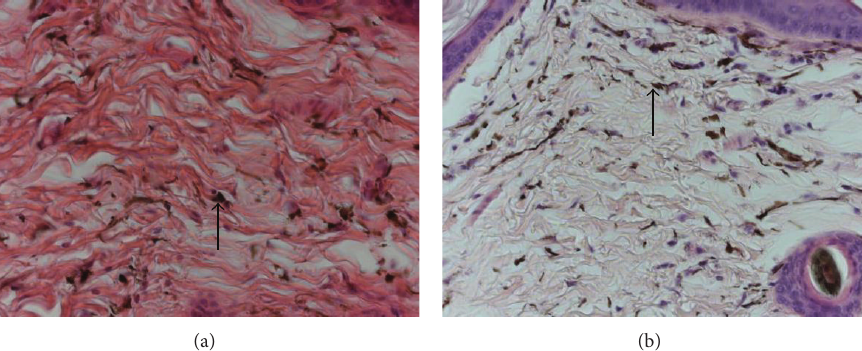
Figure 2: Photomicrographs of dermis from dorsal skin of the four-striped mouse. Pigment-containing cells (arrow) are homogeneously dispersed throughout the dermis. (a) Adult and (b) juvenile. Haematoxylin and Eosin, scale bar (a) and (b) = 2.5 𝜇